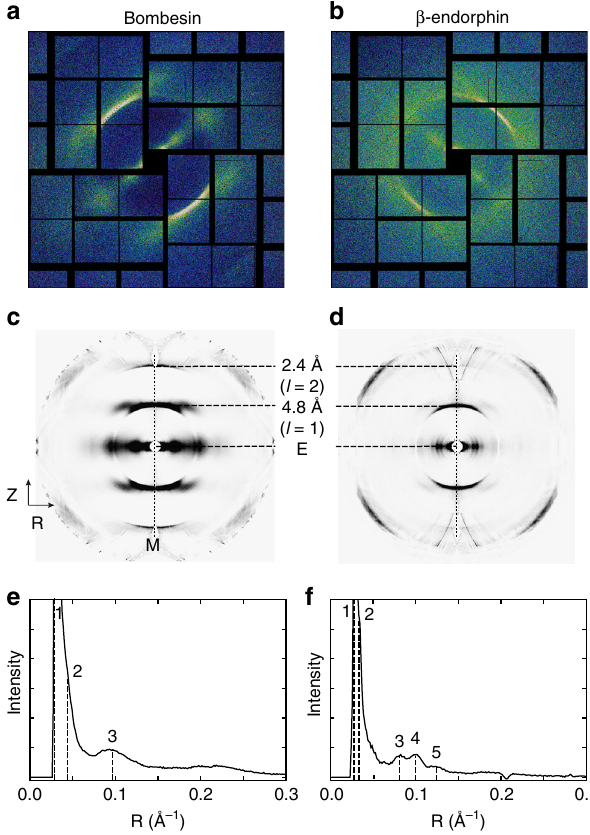
Fig. 5 XFEL Diffraction patterns obtained from amyloid fi brils. Fibrils composed of bombesin and β -endorphin are shown on the left and right, respectively. a – b Single diffraction snapshots from aligned proto fi brils, and background-subtracted merged patterns obtained from 40 diffraction snapshots each of c bombesin and d β -endorphin are shown. e , f Averaged intensity pro fi les as a function of reciprocal resolution over a band of width eight pixels (( e ) bombesin) and 22 pixels (( f ) β -endorphin) centered on the equator. Peaks in the equatorial pro fi les are marked. All peaks are